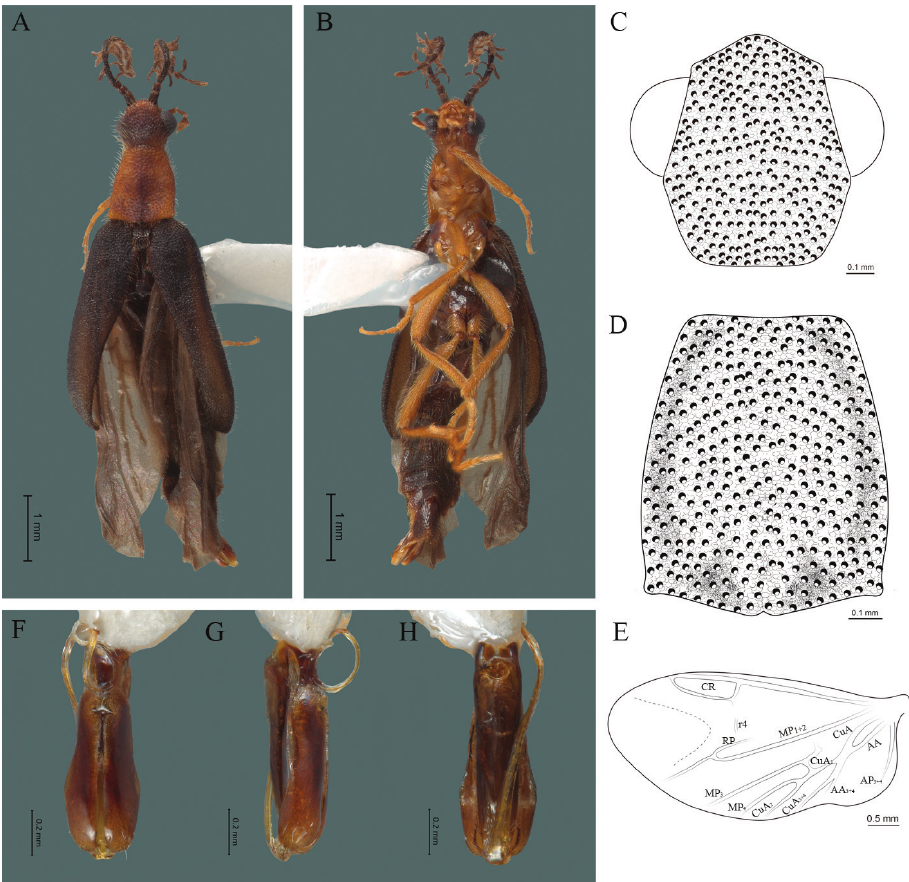
Figure 33. Cenophengus zuritai Vega-Badillo, Morrone & Zaragoza-Caballero, sp. nov., male. Habitus: A dorsal B ventral C head dorsal D pronotum E hind wing. Wing venation: CR = Radial Cell; r4 = radial 4 vein; RP = Posterior Radial vein; MP1+2 = Posterior Median vein; CuA = Cubital vein; AA and AP = Anterior and Posterior Anal veins. Aedeagus: F dorsal view G lateral view H ventral